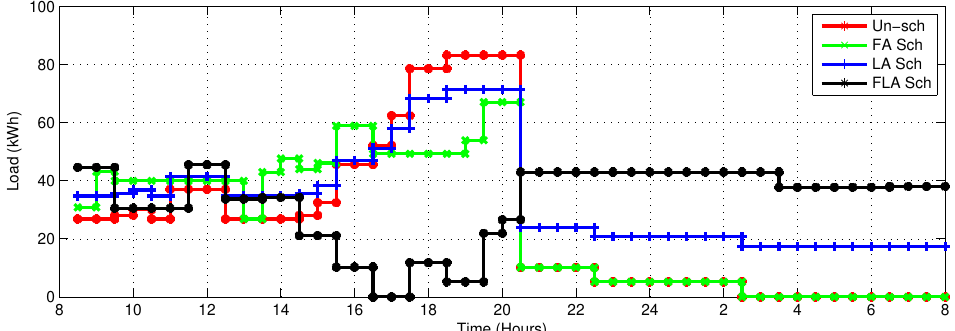
Figure 3. Hourly load distribution graph.